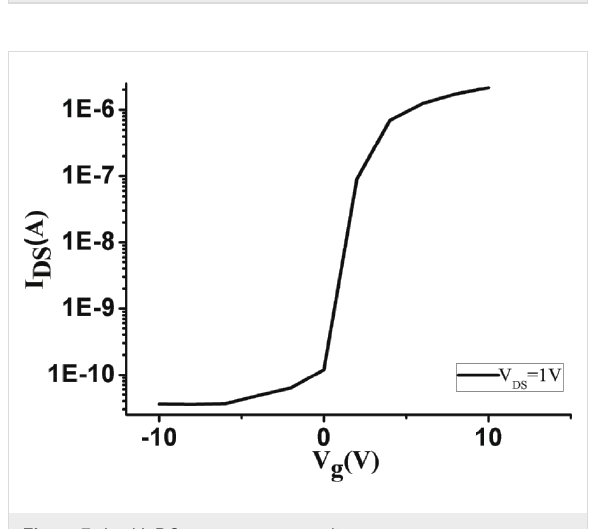
Figure 7: I ds – V g DC measurement